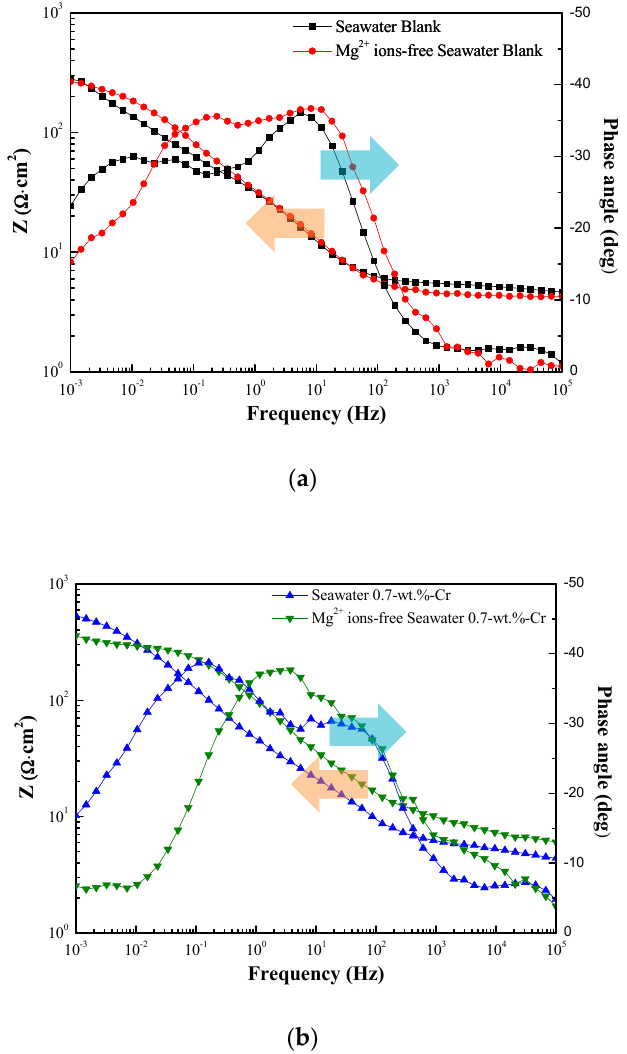
Figure 6. Bode plots for the specimens immersed in 60 °C seawater for 30 days. Specimens are ( a ) blank steels, with and without Mg 2+ ions and ( b ) 0.7-wt.%-Cr steels with and without Mg 2+ ions. The splitting of the phase angle to lower frequency means the change of capacitance.